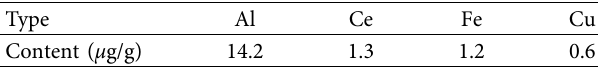
Table 2: Impurity content of fused silica optical